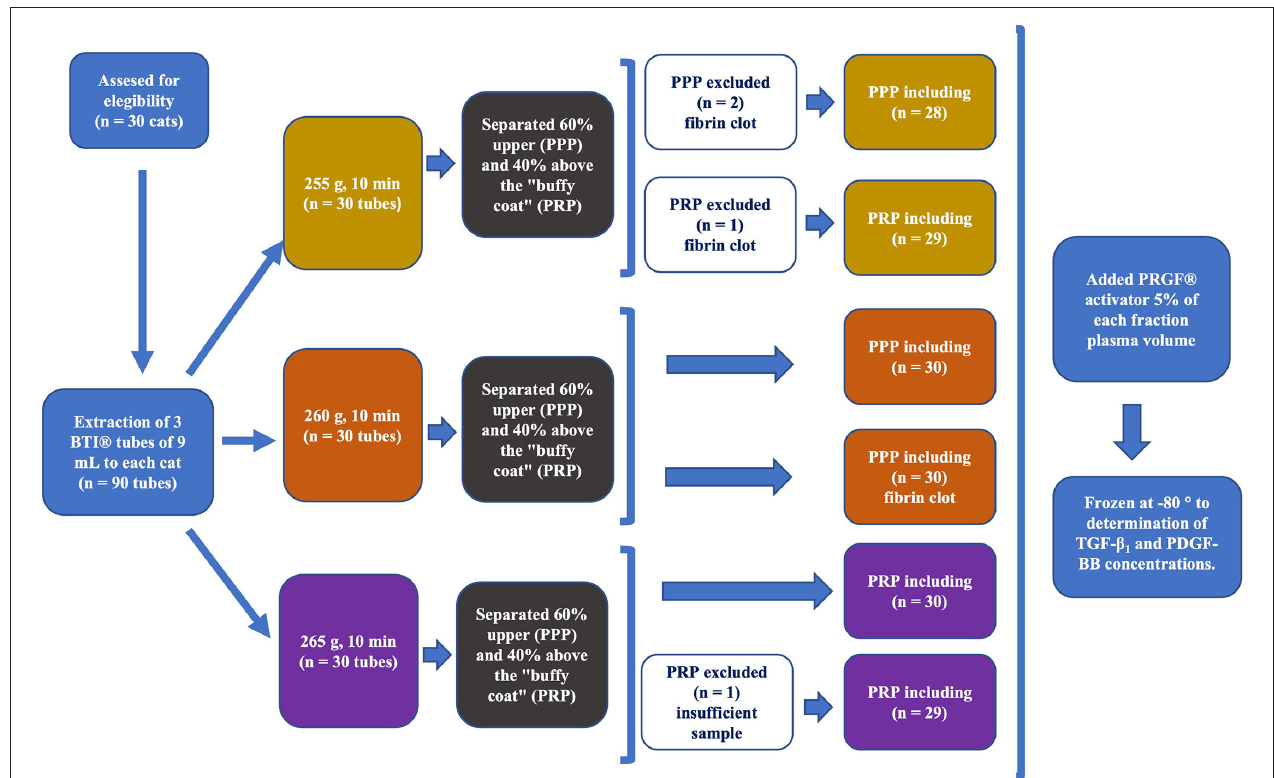
FIGURE 1 | Schematization of the study design: blood sample obtention, centrifugation following the three protocols using the PRGF®-Endoret® methodology, PRP and PPP fractions obtention, subsequent activation of both fractions with BTI-activator and freezing at − 80 ◦ C for subsequent GFs analysis.